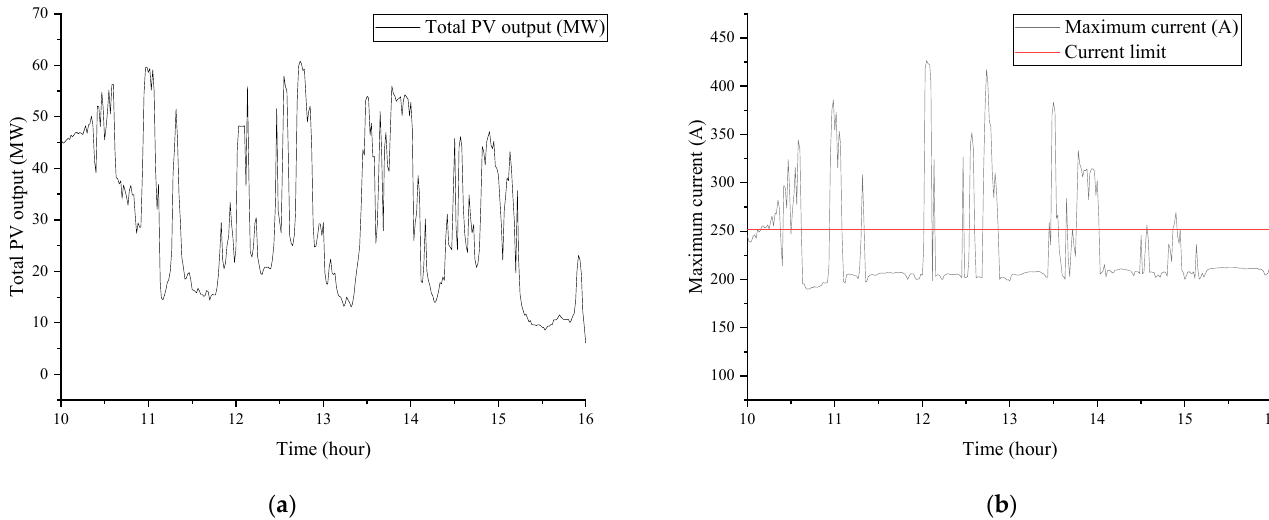
Figure 15. Profile on the 33rd day: ( a ) PV pattern; ( b ) maximum current in the system.